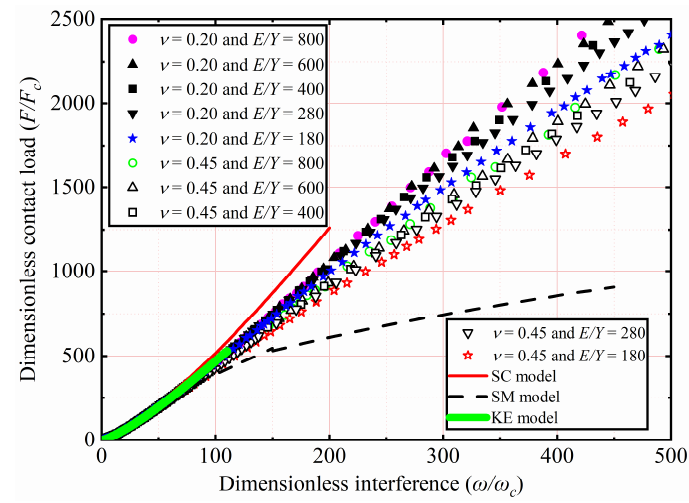
Figure 4. F/F c as a function of ω / ω c for different E and ν .